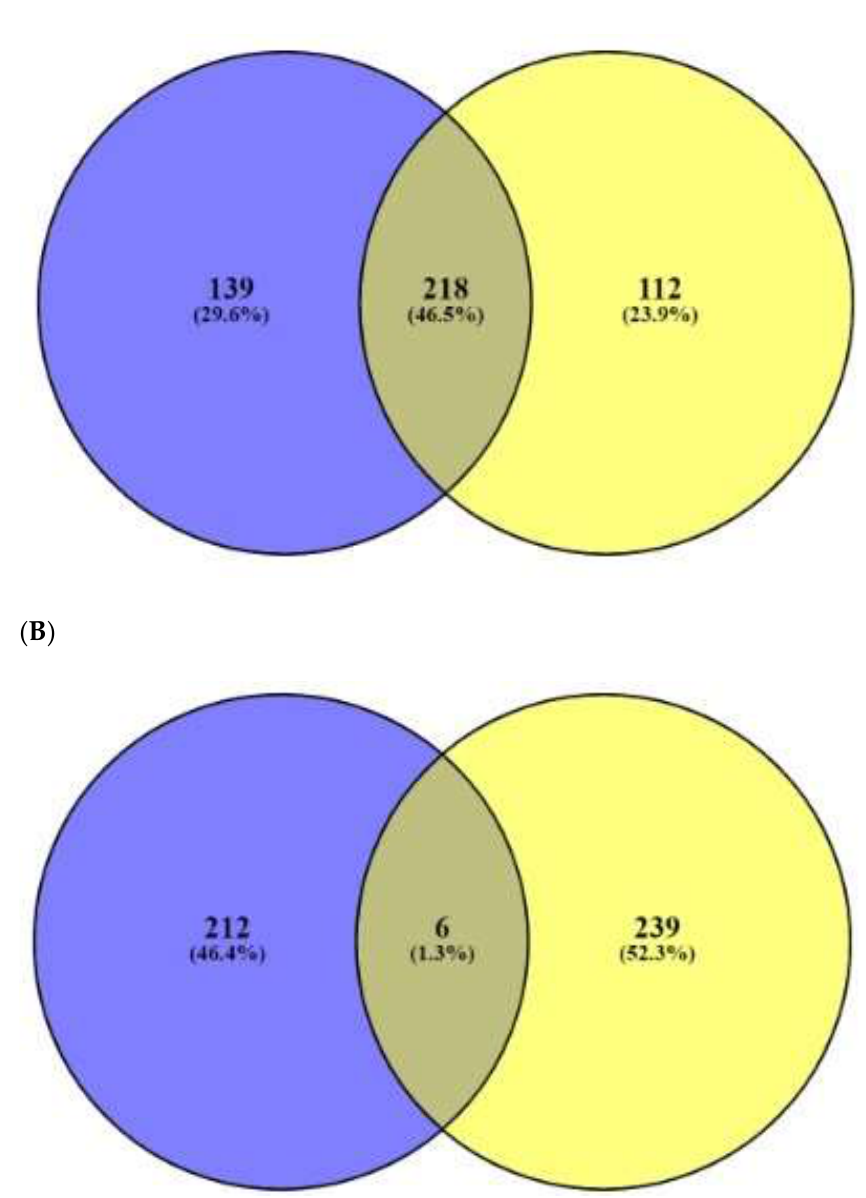
Figure 4. ( A ) The overlapping 218 targets identified by SEA (357 targets) and STP (330 targets) on AFPs’ targets. ( B ) The number of six overlapping targets between the number of 218 overlapping targets and 245 fungal-related targets.